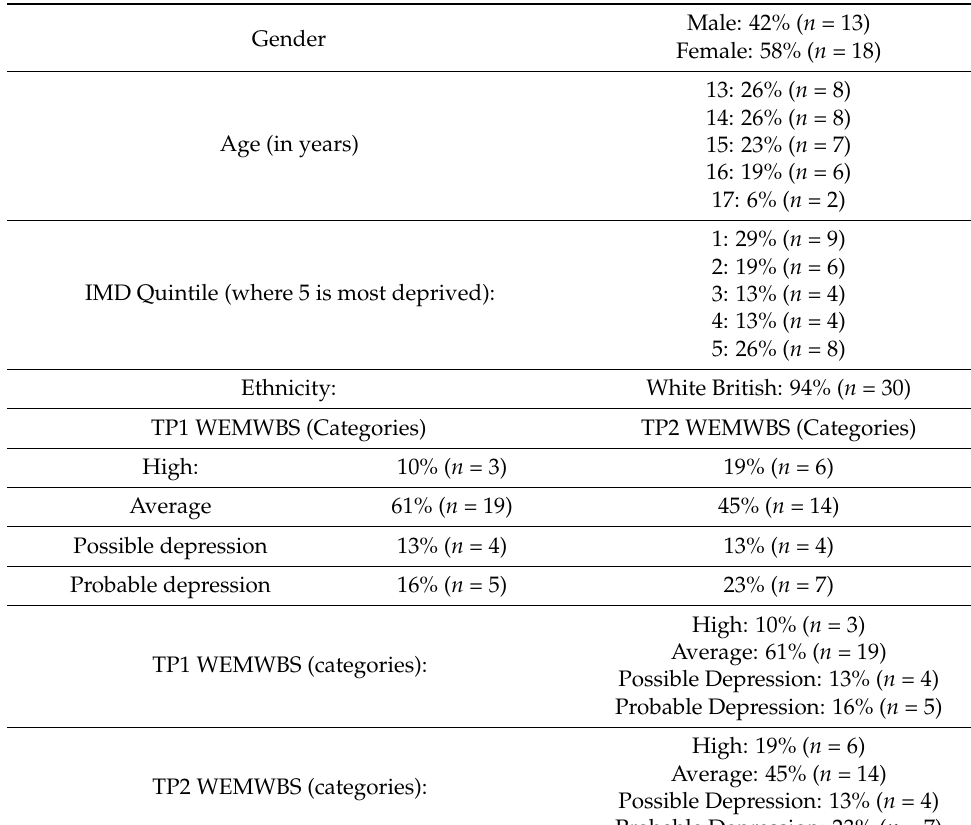
Table 1. Characteristics of Participants.